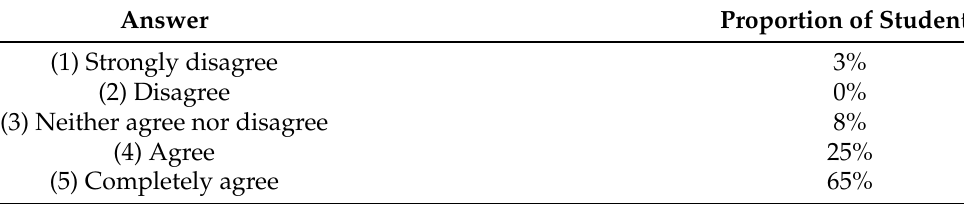
Table 3. Summary of answers to the question on the competitive assessment